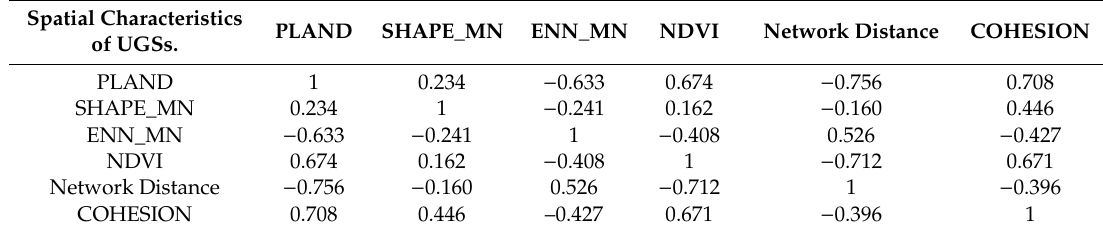
Table 3. Correlation analysis of the variables of spatial characteristics of